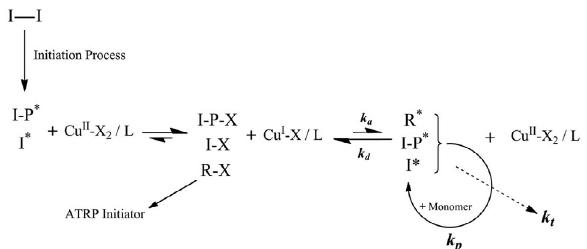
Figure 5: General mechanism for SR&NI